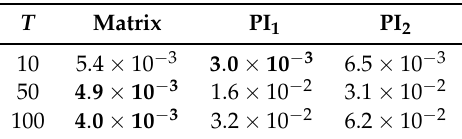
Table 1. Comparison of execution time for the matrix approach and the product integration (PI) methods for computing the approximate solution at T .